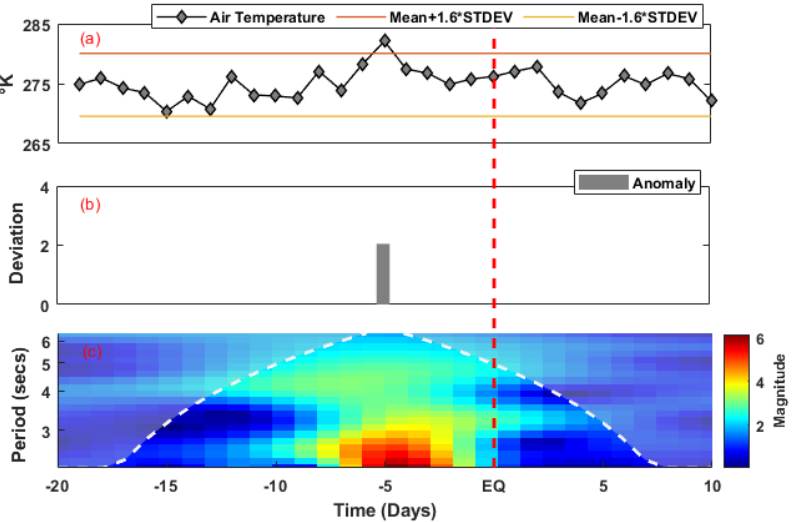
Figure 6. ( a ) Averaged time series data of AT with con fi dence bounds, ( b ) The deviation of AT values from con fi dence bounds, ( c ) Wavelet transformation of AT time series data. The white dashed line marks cone of in fl uence and red dashed line shows the earthquake day. The * is for multiplication.